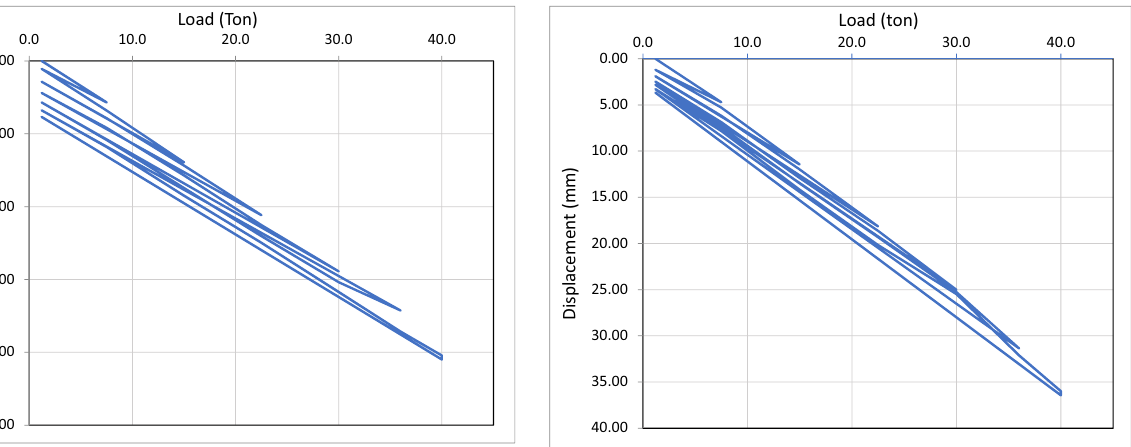
Figure 8: Load – displacement curve for anchor 1.